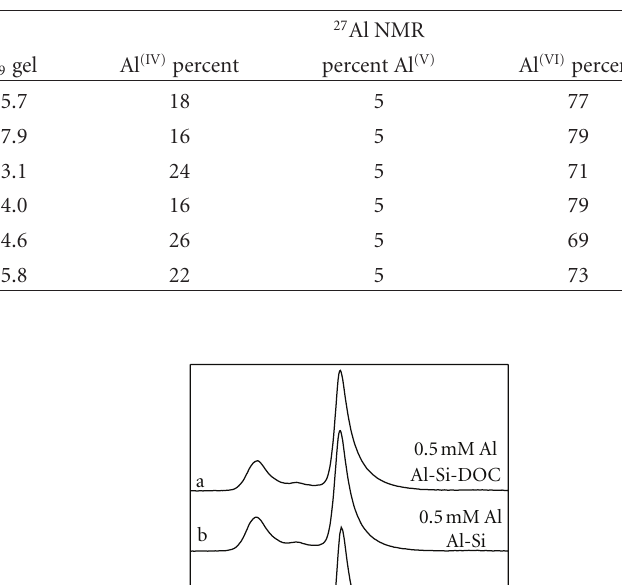
Table 4: The percentage of imogolite-like Si from 29 Si NMR, corresponding to the integrated relative intensity of the peak at − 78.3 ppm. The δ Si-29 of the gel component is the weighted average of the broad signal, excluding the imogolite-like peak. Also reported is the percentage of Al in 4-, 5-, and 6-fold coordination from 27 Al NMR.